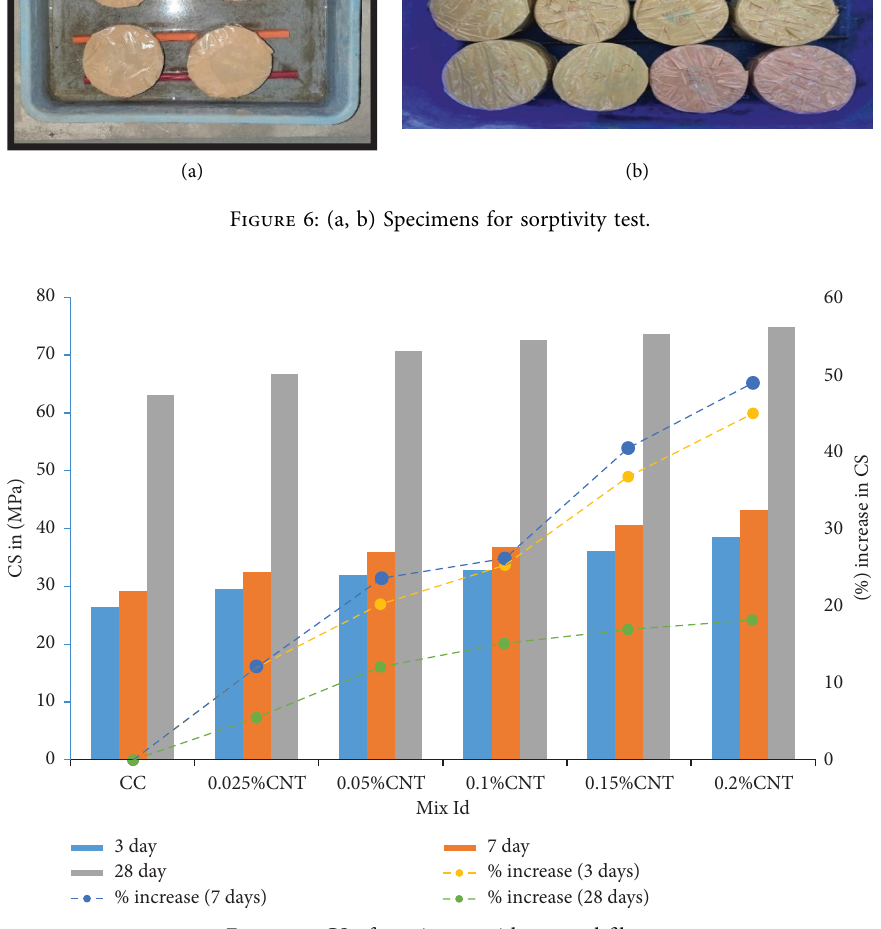
Figure 7: CS of specimens without steel fbre.